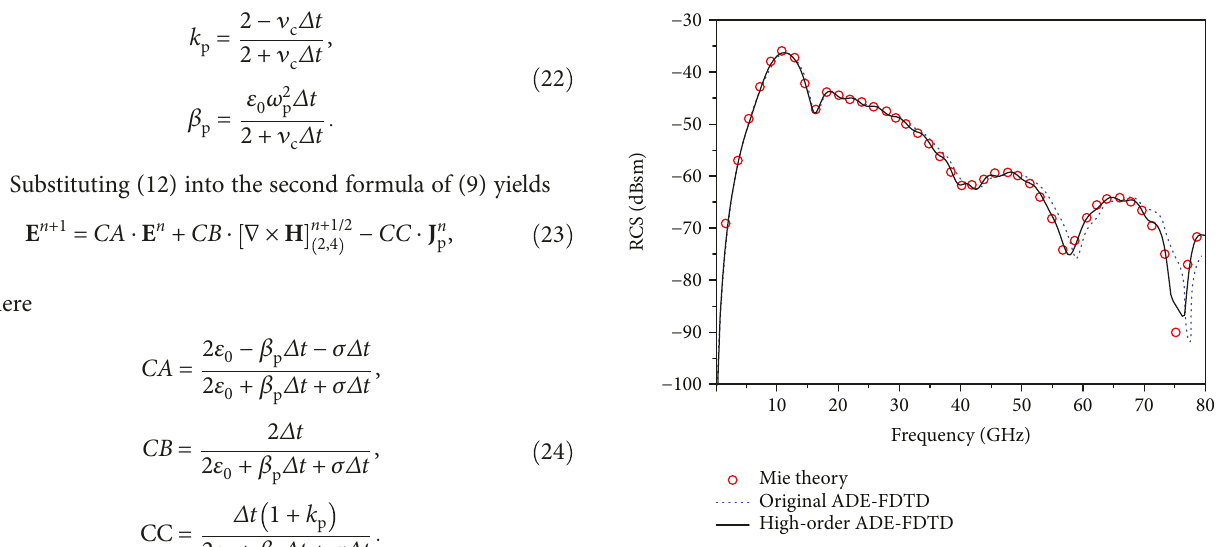
Figure 3: Comparison of backward RCS of a plasma sphere obtained using di ff erent methods. The frequency is in the range of 0.1 ~ 80 GHz. The radius of the plasma sphere is r = 3 75 mm . The plasma frequency is ω p = 1 8 × 10 11 rad/s , and the collision frequency is ν c = 2 0 × 10 10 Hz